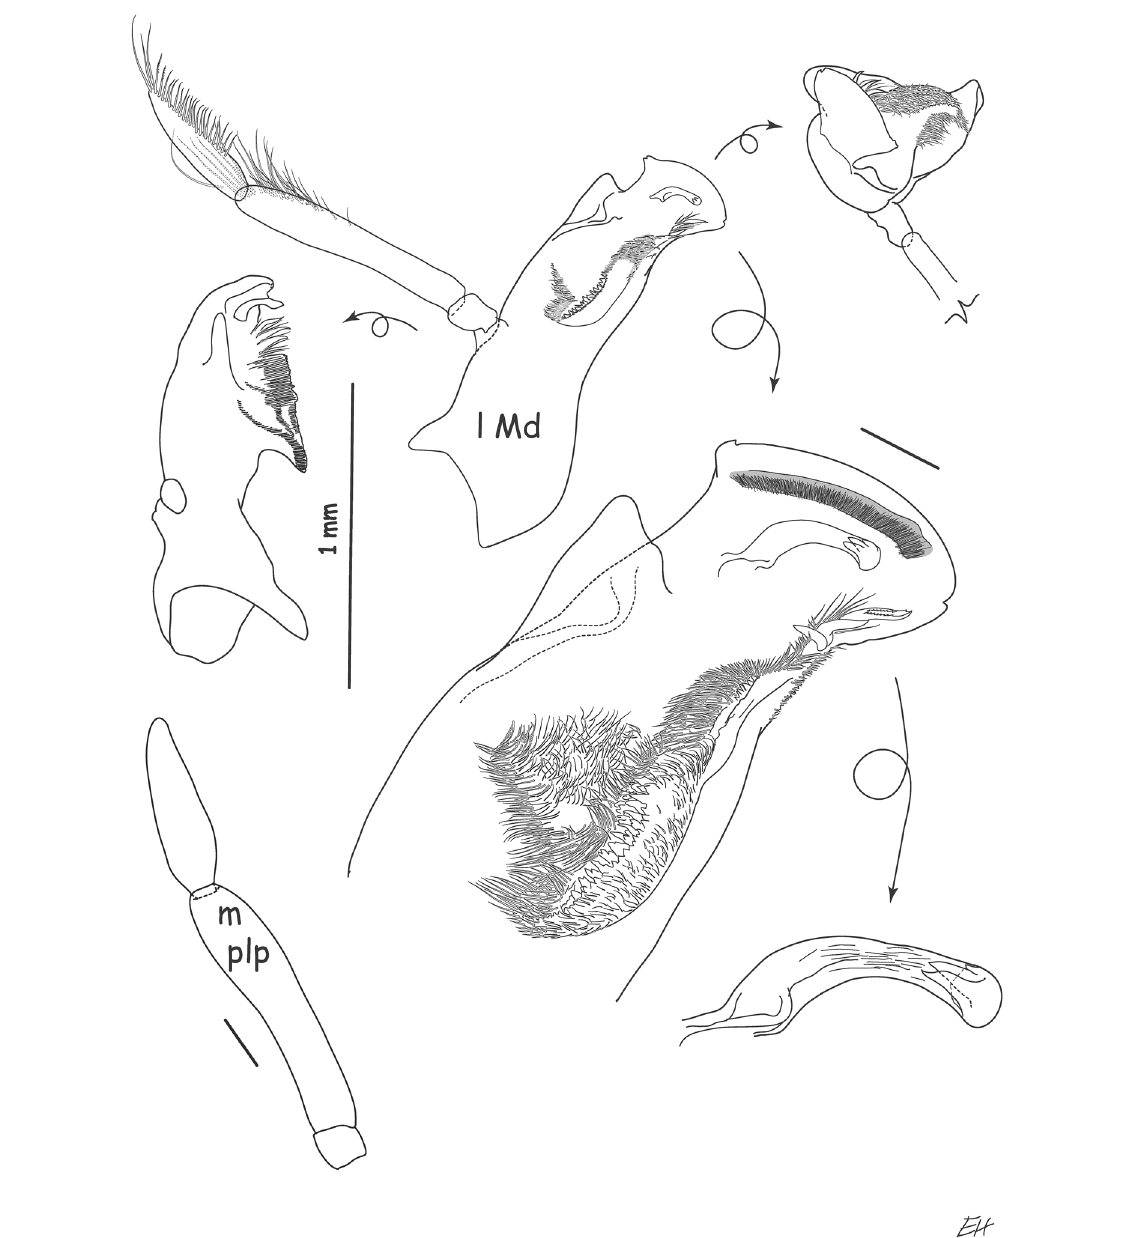
Fig. 29. Abyssorchomene shannonae sp. nov., holotype, ♀, 12 mm (ZMH K-61209); allotype, ♂, 7 mm (ZMH K-61210). From left to right: dorsolateral, medial and frontal aspects of Md. Setae omitted on male Md palp. Figures with sex not indicated are of female. Scale bars = 0.1 mm unless indicated